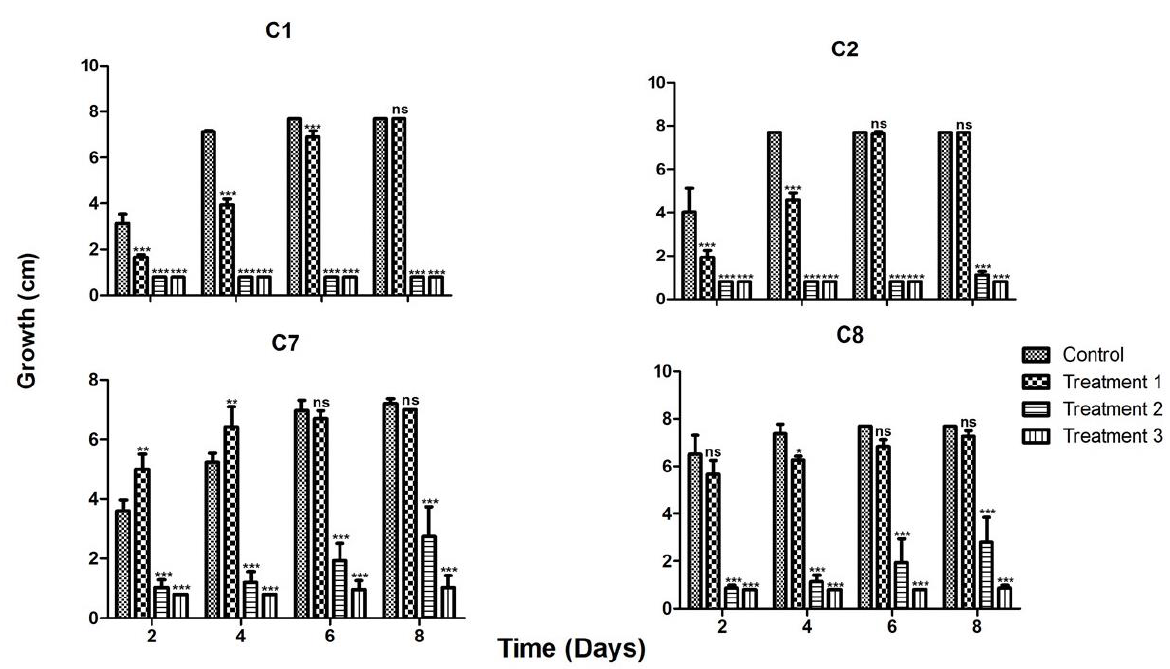
Figure 3. Behavior of the four most tolerant strains in the presence of the three metals in three treatments. The strain’s code is depicted up at the center for each group of the four graphs, growth is depicted by bars in the figures for the following treatments. Treatment 1 contained: 50 ppm Cu, 300 ppm Zn and 600 ppm Pb; treatment 2 contained: 100 ppm Cu, 950 ppm Zn and 1800 ppm Pb; and treatment 3 contained: 200 ppm Cu, 1600 ppm Zn and 4000 ppm Pb. * = p < 0.05, ** = p < 0.01, *** = p < 0.001, ns = no significant difference.